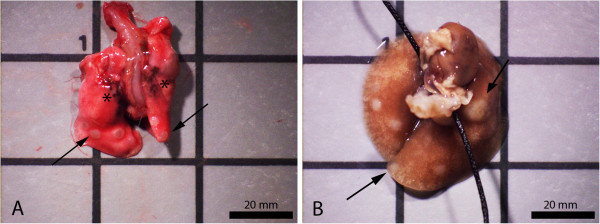
Gross images of lung tumors promoted by GMA-SS welding PM 30 weeks after initiation with MCA. Panel A represents the lung tumor morphology before fixation panel B is 24 h after fixation. Asterisks (*)-indicate areas of welding PM deposition. The arrows (↑)-indicate lung tumors. The majority of tumors were ~1 mm in diameter.